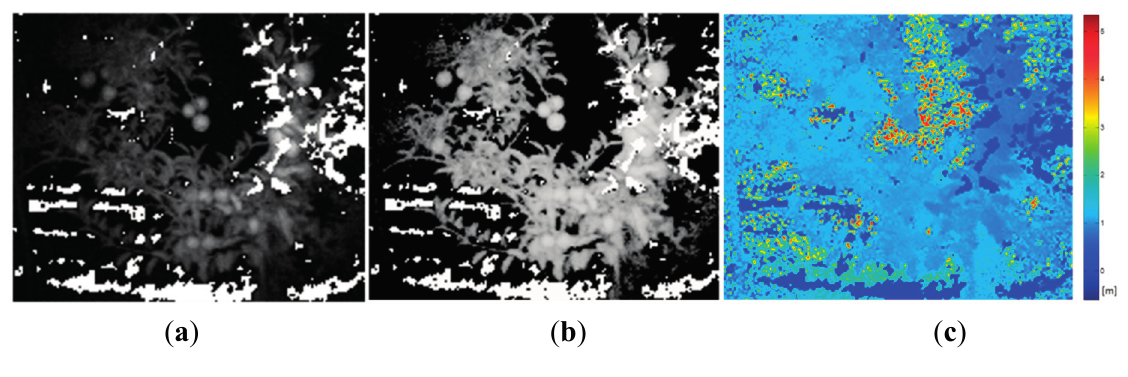
Figure 11. Data acquired with the TOF camera – Vineyard. ( a ) TOF amplitude data; ( b ) TOF camera confidence map; ( c ) Z-axis range data acquired with the TOF camera.